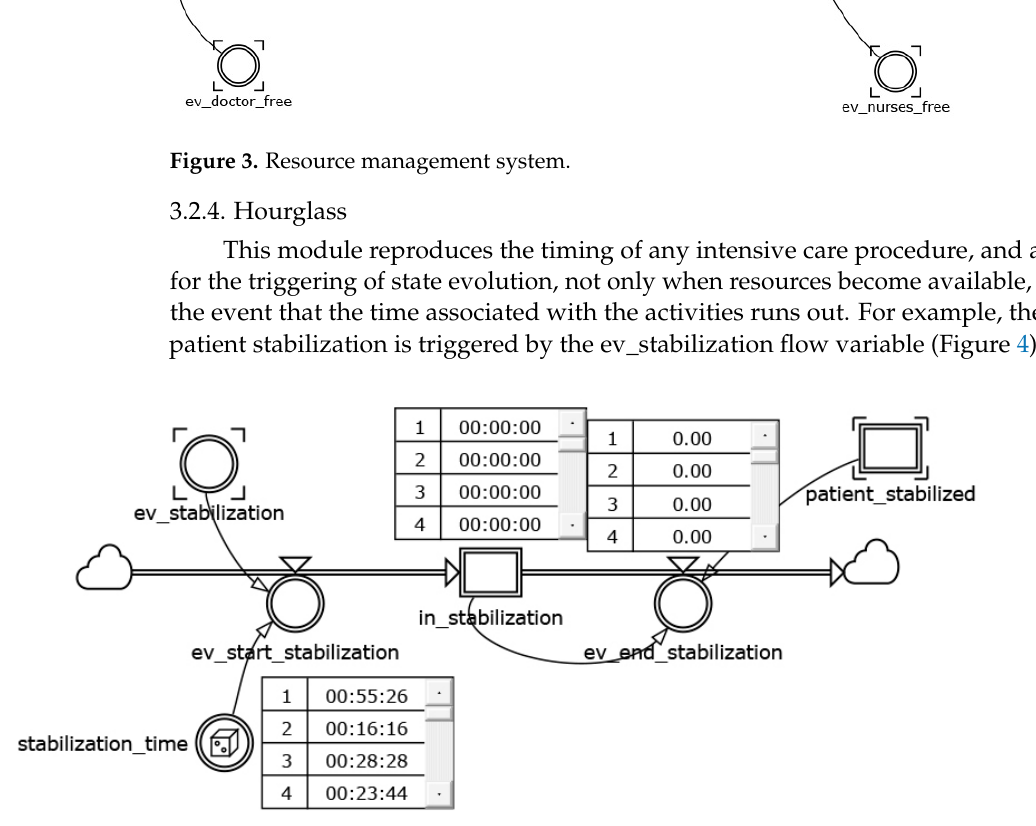
Figure 4. A detail of hourglass consumption of time mechanism.